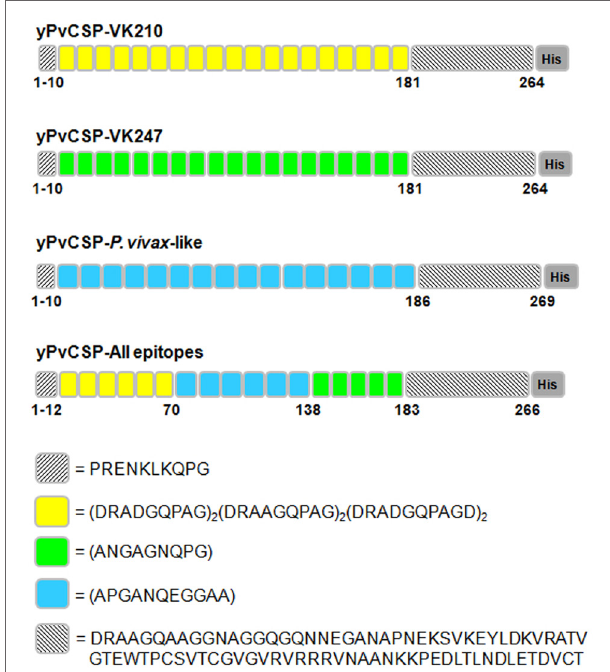
FigUre 1 | Schematic representation of the Plasmodium vivax circumsporozoite protein (CSP) recombinant antigens. The individual recombinant proteins have the specific individual repeats [yPvCSP-VK210 ( n = 19), yPvCSP-VK247 ( n = 19), or yPvCSP- P. vivax -like ( n = 16)] and the C-terminal (CT) region. For each repeat sequence, the amino acids positions and the histidine tag are indicated. The classic repeat sequence VK210 is represented in yellow, VK247 in green, and P. vivax -like in blue. The yPvCSP-All epitopes merges the repeats of all three allelic variants describe above ( n = 6/6/5 repeat sequences of VK210/ P. vivax -like/VK247, respectively) and the CT